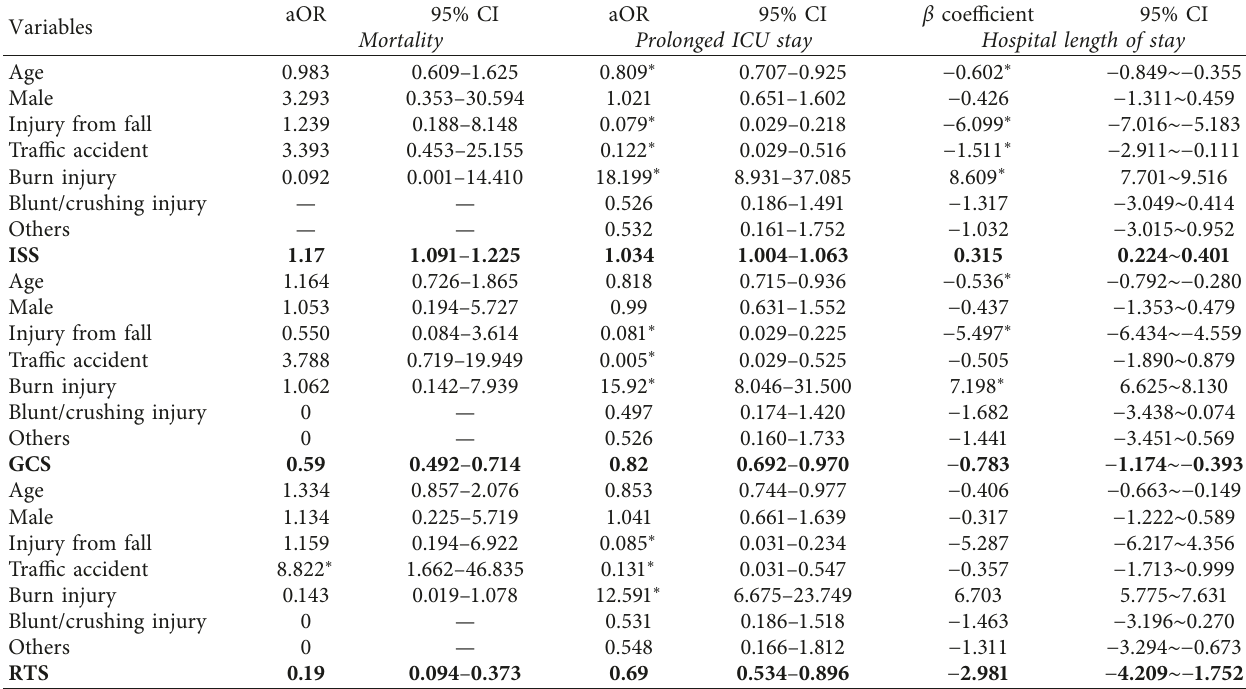
Table 3: Logistic regression for trauma score to mortality, prolonged ICU stay, and hospital length of stay (after adjusting for age, gender, and cause of